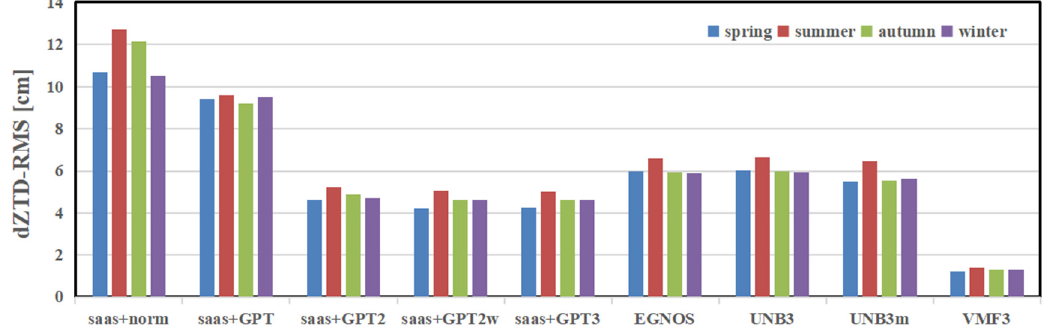
Figure 4. RMS between the IGS ZTD and the 9 models (saas+norm/GPT/GPT2/GPT2w/GPT3, EGNOS, UNB3, UNB3m, VMF3) in different seasons.